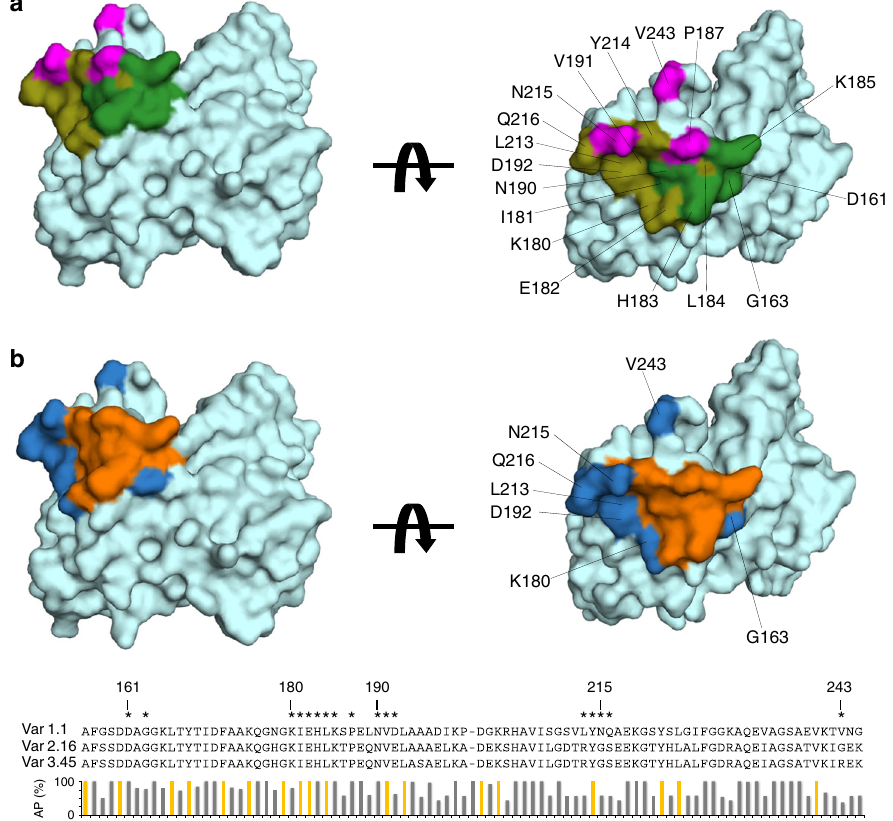
Fig. 5 The 1A12 epitope and its allelic diversity in the fHbp global gene repertoire. a Two views of the 1A12 epitope “ footprint ” on the surface of fHbp. Residues contacted by the heavy chain are highlighted in green and olive colors for polar and VDW interactions, respectively. The contacts made by the light chain are in magenta. Asn215 establishes polar contacts with both the heavy and light chains. b Allelic diversity in the 1A12 epitope. Upper panel: residues within the 1A12 epitope with a degree of conservation > 99% in all fHbp gene repertoire are colored orange; residues with a prevalence lower than 99% are shown in dark blue and labeled with their position number. Bottom panel: sequence alignment of fHbp var1.1, 2.16, and 3.45. (The gap at position 200 – 201 re fl ects one subvariant of 984 that presents a single-residue insertion (Trp) at this position. Despite the gap, the numbering shown above the alignment corresponds to the numbering used in the main text). The allelic prevalence among 984 fHbp sequences is shown for each position in the 1A12 epitope 31 . Orange columns depict sites non-polymorphic in all 984 sequences known. The residues that form the 1A12 epitope are indicated with an